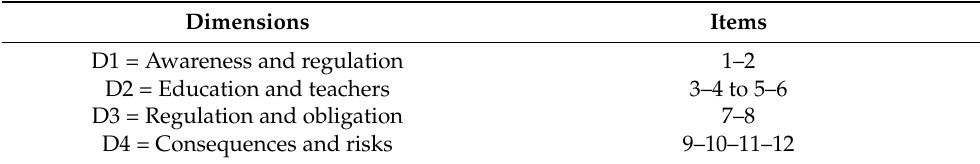
Table 1. Structure of the instrument in dimensions.